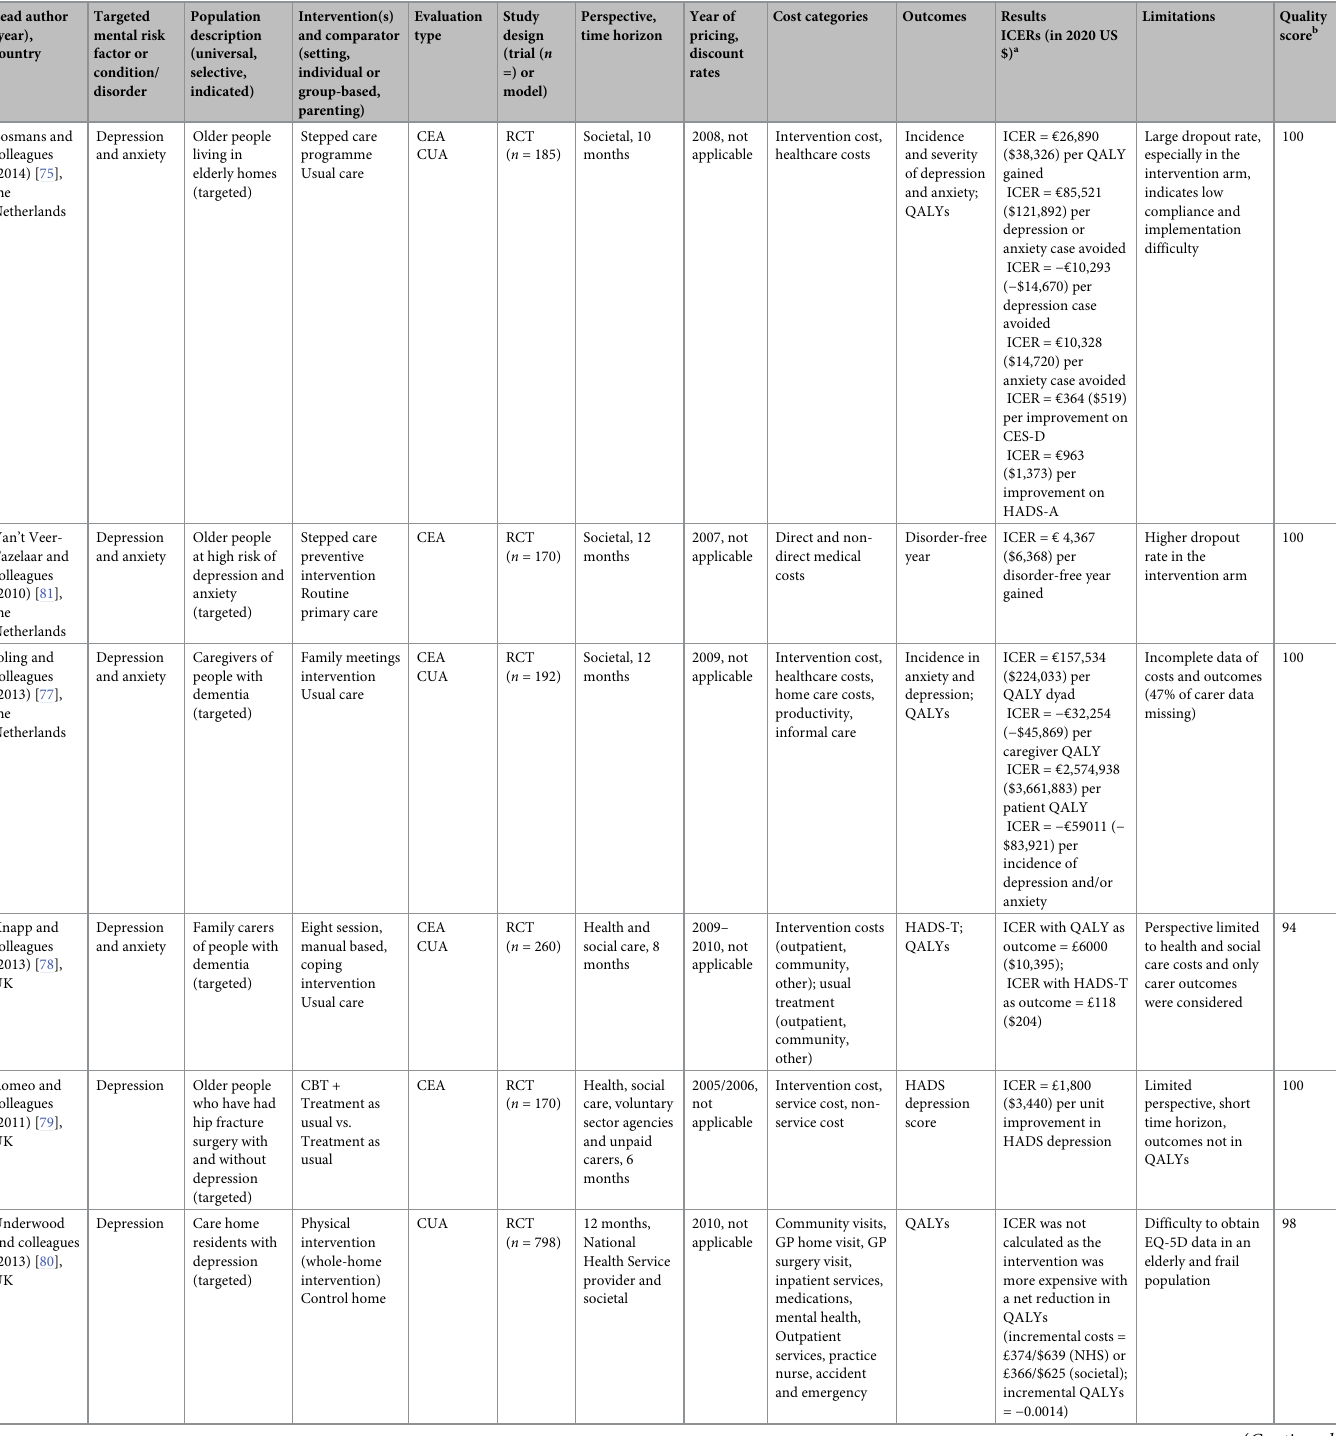
Table 3. Characteristics of studies included—older adults. Leadauthor